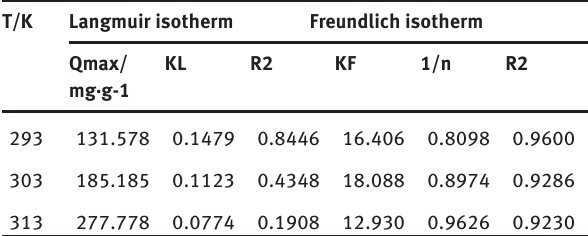
Table 3: Fitting results of Cu 2+ adsorption isotherms on the fermented Magnolia officinalis